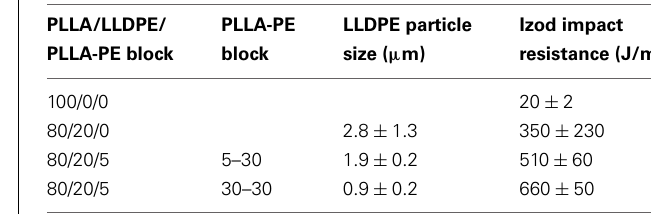
Table 10 | Particle size analysis and impact resistance of PLLA homopolymer and blends [Copyright (2003) Wiley; used with permission from Anderson et al.